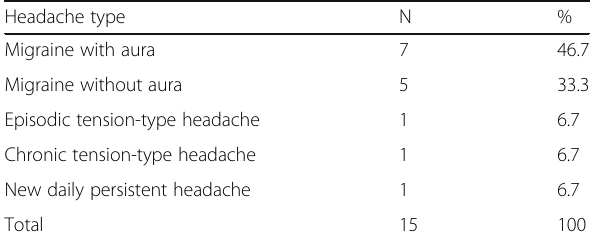
Table 2 Concurrent primary headaches in AH patients